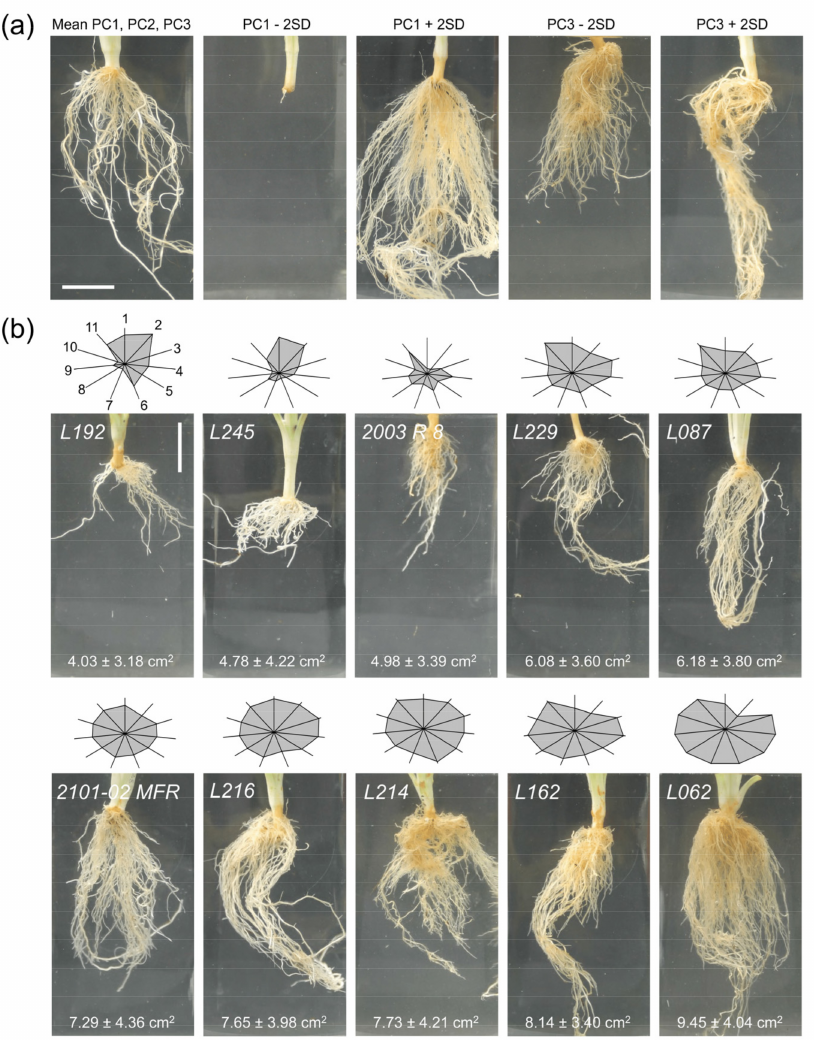
Figure 6. The double cross F 1 hybrid lines with extreme rooting phenotypes studied in the third experiment. ( a ) Representative images corresponding to plus or minus two times the standard deviation ( + 2 SD and − 2 SD) for PC1 and PC3. ( b ) The stars and rays graphs highlight the di ff erences between genotypes. Each axis represents one parameter, and its intersection with the polygon sides indicates the relative magnitude for that parameter: (1) shoot fresh weight at planting time, (2) cutting length at planting time, (3) shoot water content, (4) shoot growth, (5) root water content, (6) average root width, (7) root area, (8) root convex area, (9) root depth, (10) root length, and (11) rooting response. Parameters 3 to 11 were measured at 40 dap. Representative images for the studied F 1 lines are sorted by average root area values from the worst rooting line ( L192 ) to the best rooting one ( L062 ). Scale bar: 20